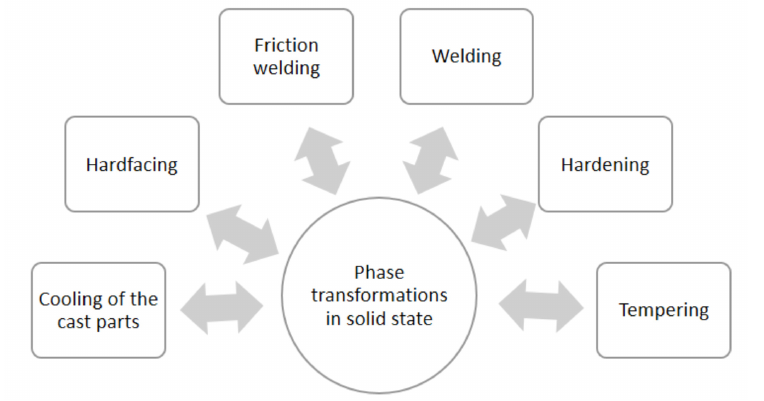
Figure 1. Examples of processes in which phase transformations in the solid state should be taken into account during